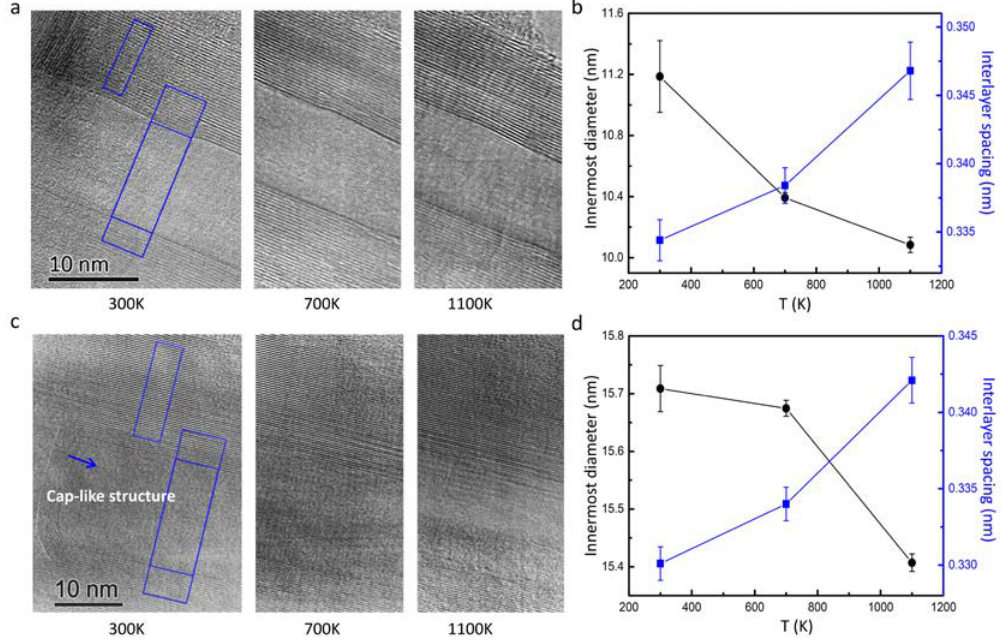
Figure 3. High-resolution lattice images of BNNTs from in situ TEM heating experiments. ( a ) High-resolution lattice images of BNNTs taken at 300, 700 and 1100 K, respectively; ( b ) the corresponding lattice spacings of the axial and radial directions for the three temperatures; ( c , d ) are the same as ( a , b ), but for nanotubes with a cap-like structures.